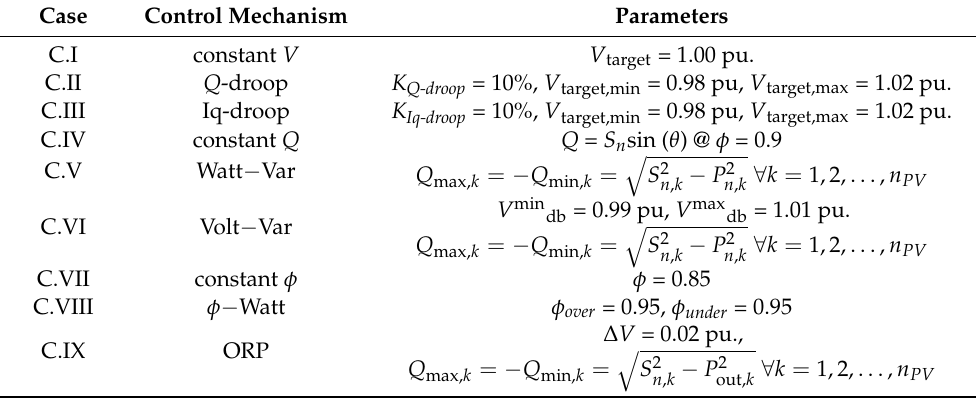
Table 1. Study cases and parameters of the reactive power control mechanisms enabled at the PVs.